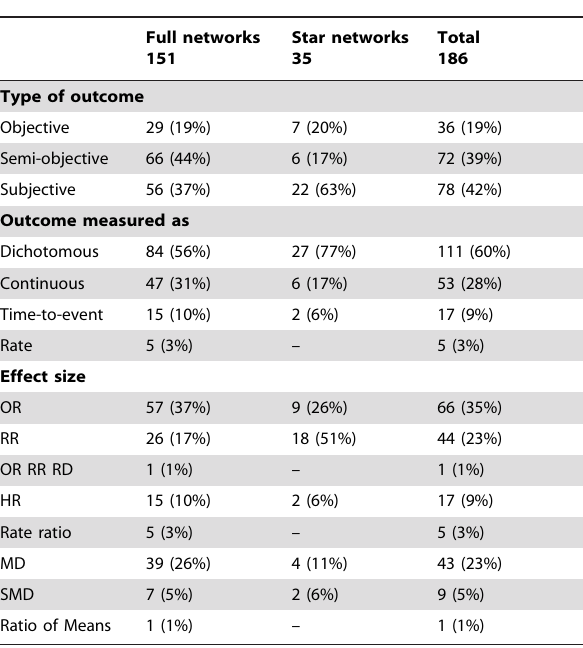
Table 4. Characteristics of the primary outcomes and their measures in full and star networks published until